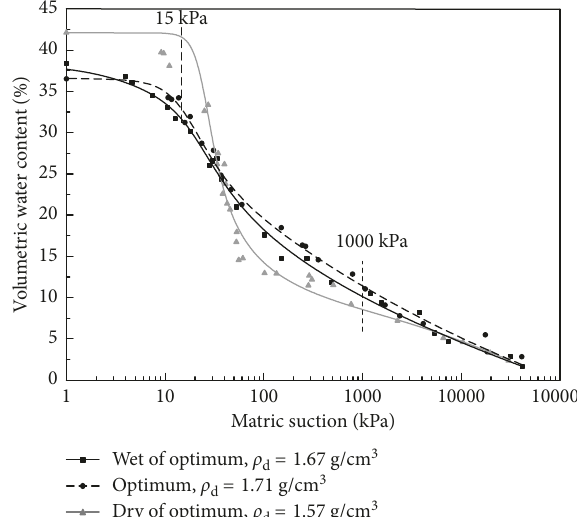
Figure 9: Wetting soil-water characteristic curves of specimen compacted at different initial water contents.